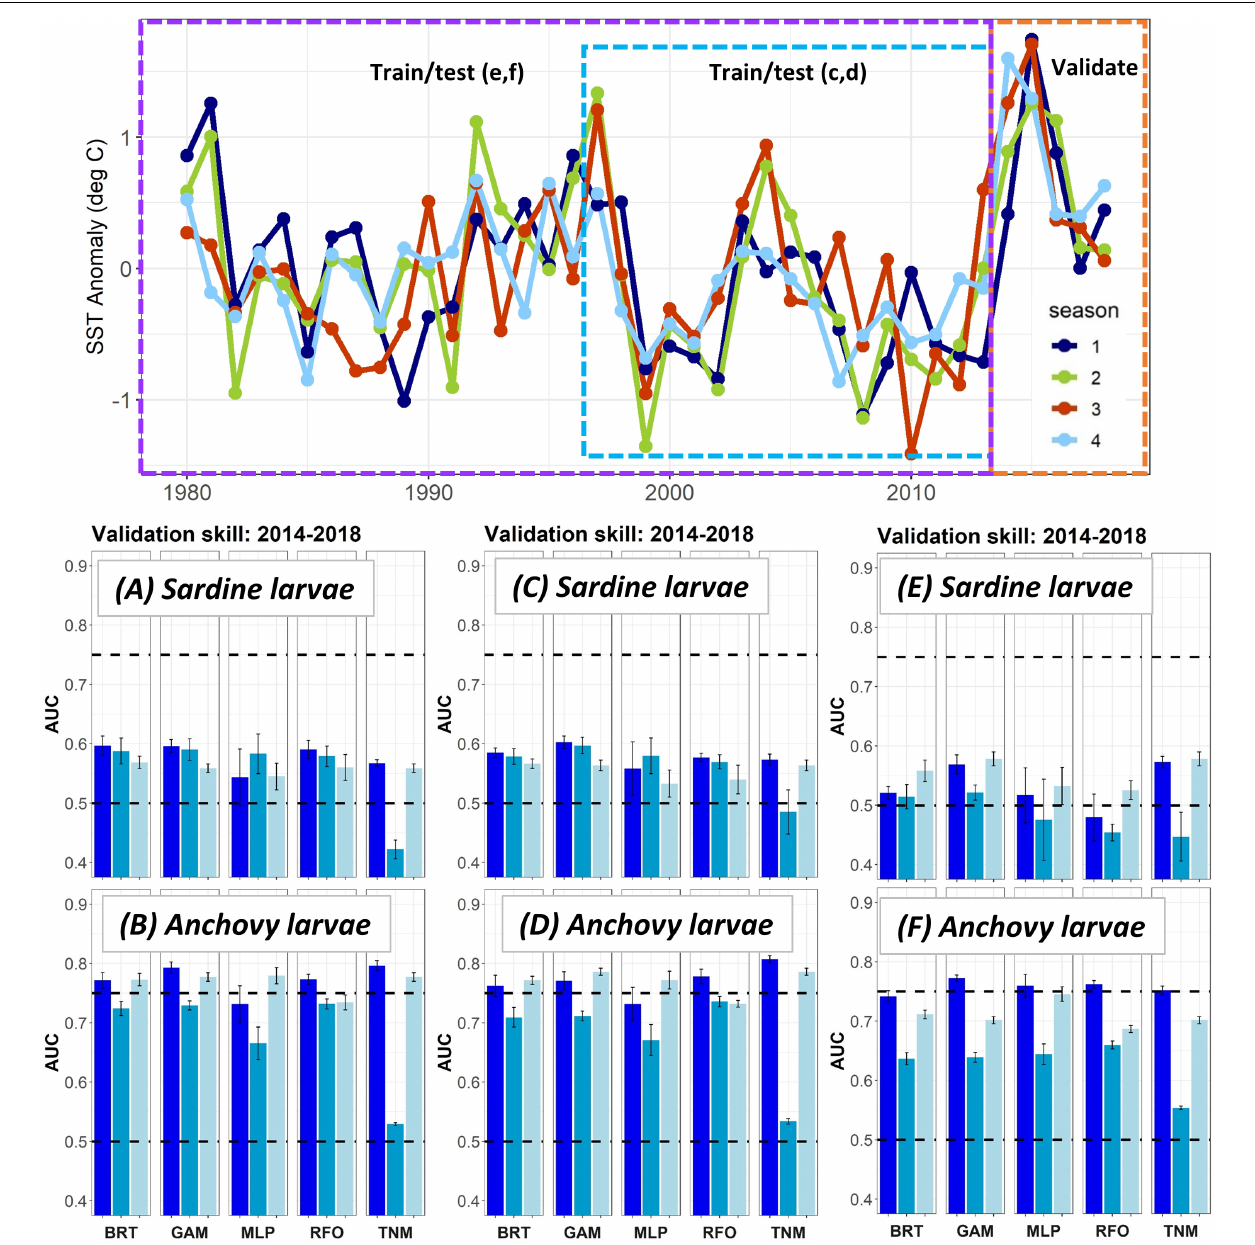
FIGURE 4 | SST anomalies averaged across the ROMS domain from 1980 to 2018 (top) , and validation AUCs for years 2014–2018 for larval sardine and larval anchovy SDMs trained using data from (A,B) 2003–2013 (i.e., Experiment 1), (C,D) 1997–2013, (E,F) 1980–2013. Means and standard deviations across all SDM ensembles (see Figure 1 ) are shown for each life stage of each species. Colors of bars denote the SDM configuration (“all,” “env,” or “geo”). The horizontal black dashed lines show AUC values of 0.5 (no better than a random model), and 0.75 (a rough approximation of a “useful” model), for